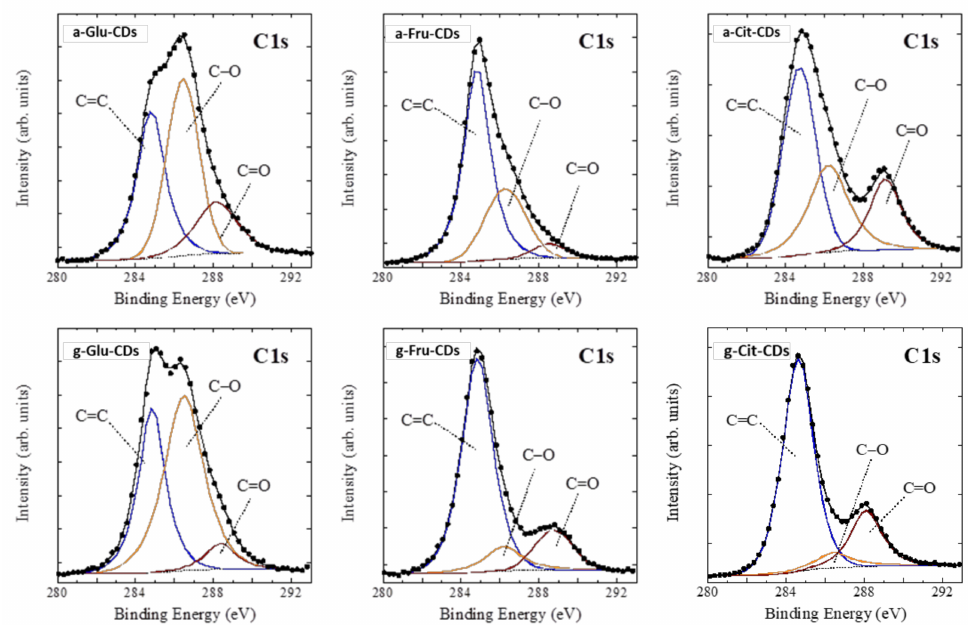
Figure 3. C1 XPS spectra of all the CDs samples. The binding energy (BE) was corrected for surface charging.